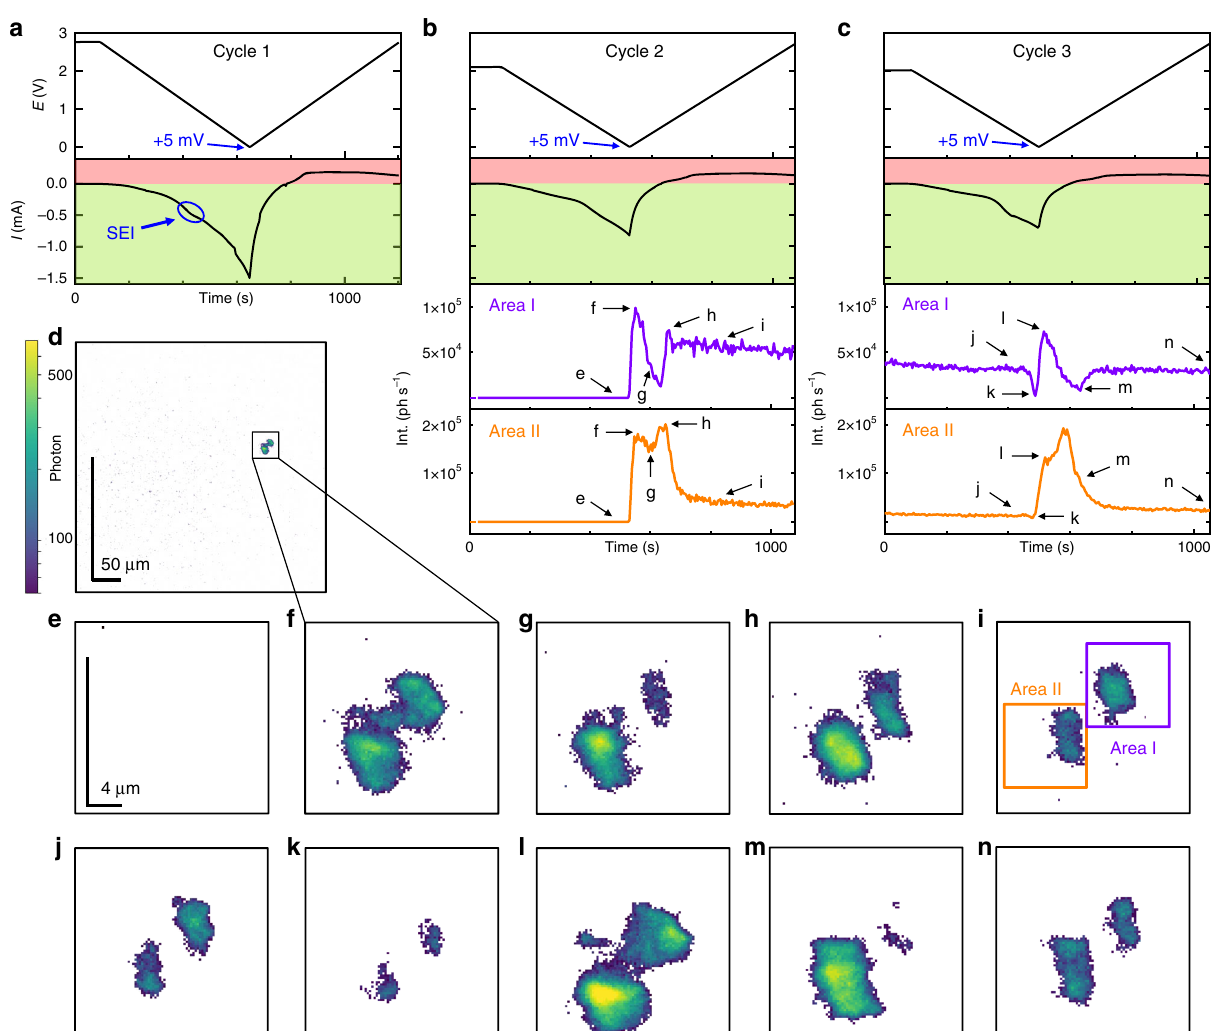
Fig. 2 Evolution of the early-stage defects from cycle 1 to 3. Potential (E) and current (I) of the 1st cycle ( a ). The E, I, and the integrated scattered intensity (Int) of the 2nd ( b ) and 3rd ( c ) cycle are shown separately for Area I and II. The light green and light red background in a – c illustrate the current for lithiation (negative currents) and delithiation (positive currents), respectively. d shows the complete FoV of 100 × 430 μ m 2 . e – n show the evolution of the observed defects at a higher magni fi cation. The labels of e – n match the marked annotations in b and c , corresponding to the instants of time at which the FFDXM images were taken.